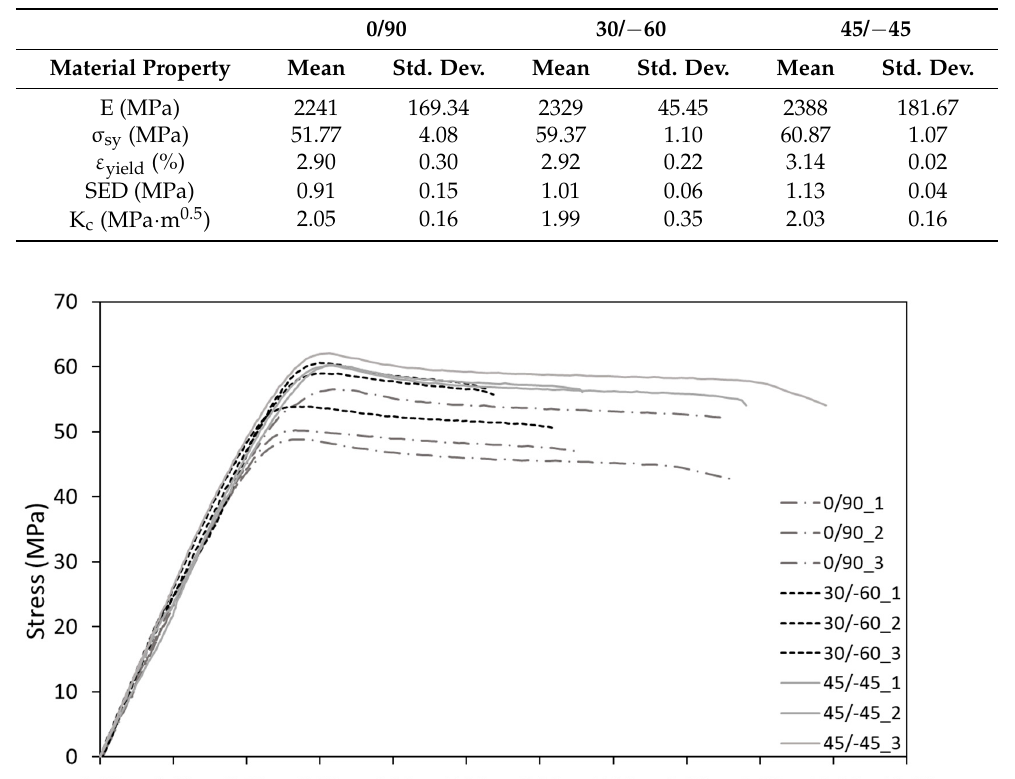
Table 2. ABS AM mechanical properties; E, Young ´ s modulus; σ sy , tensile strength at yield; ε yield , strain at yield; SED, strain energy density; K c , fracture resistance.